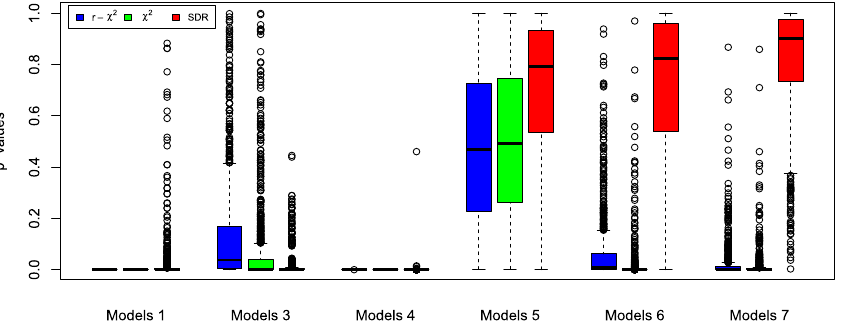
Figure 1: Boxplot of p-values among 1000 replications. The left, middle, and right boxes represent p-values of the robust and the ordinary χ 2 tests in Crump etal. [11], and the proposed χ 2 test,